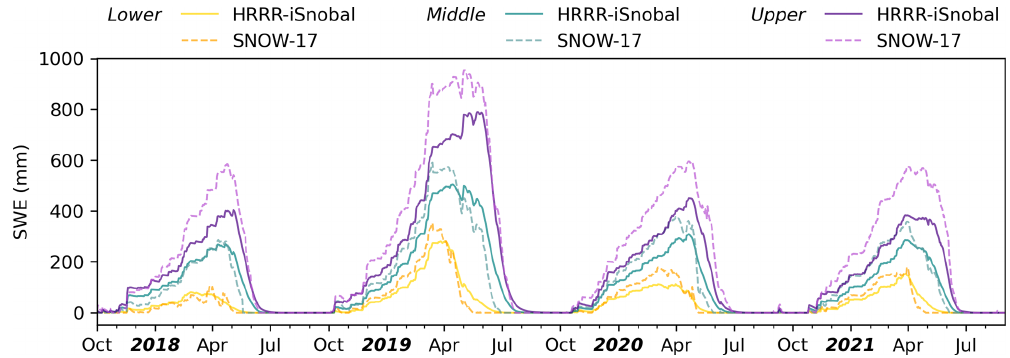
Figure 8. Total SWE comparison per HRU across 4 years between SNOW-17 (dashed lines) and HRRR-iSnobal (solid